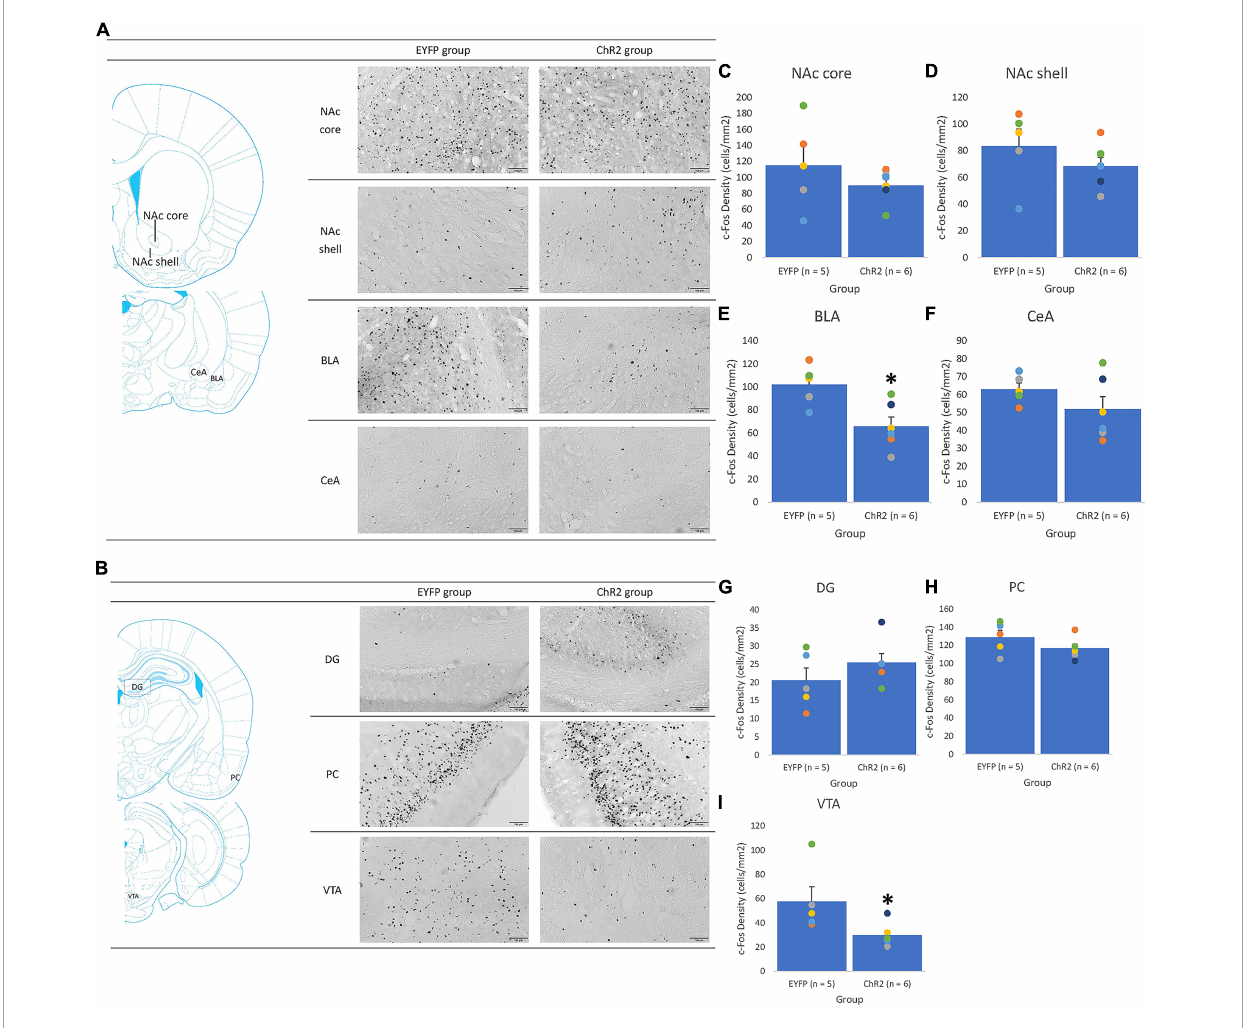
FIGURE7 The PrL photostimulation was given in conditioning. An illustrated brain atlas showing (A) the nucleus accumbens core (NAc core), nucleus accumbens shell (NAc shell), basolateral amygdala (BLA), and central amygdala (CeA); (B) the dentate gyrus (DG), piriform cortex (PCl), and ventral tegmental area (VTA); c-Fos density in the (C) NAc, (D) NAc shell, (E) BLA, (F) CeA, (G) DG, (H) PC, and (I) VTA for the EYFP ( n = 5) and ChR2 ( n = 6) groups after PrL optical stimulation and morphine-induced CTA in extinction. ∗ p < 0.05 compared with the EYFP